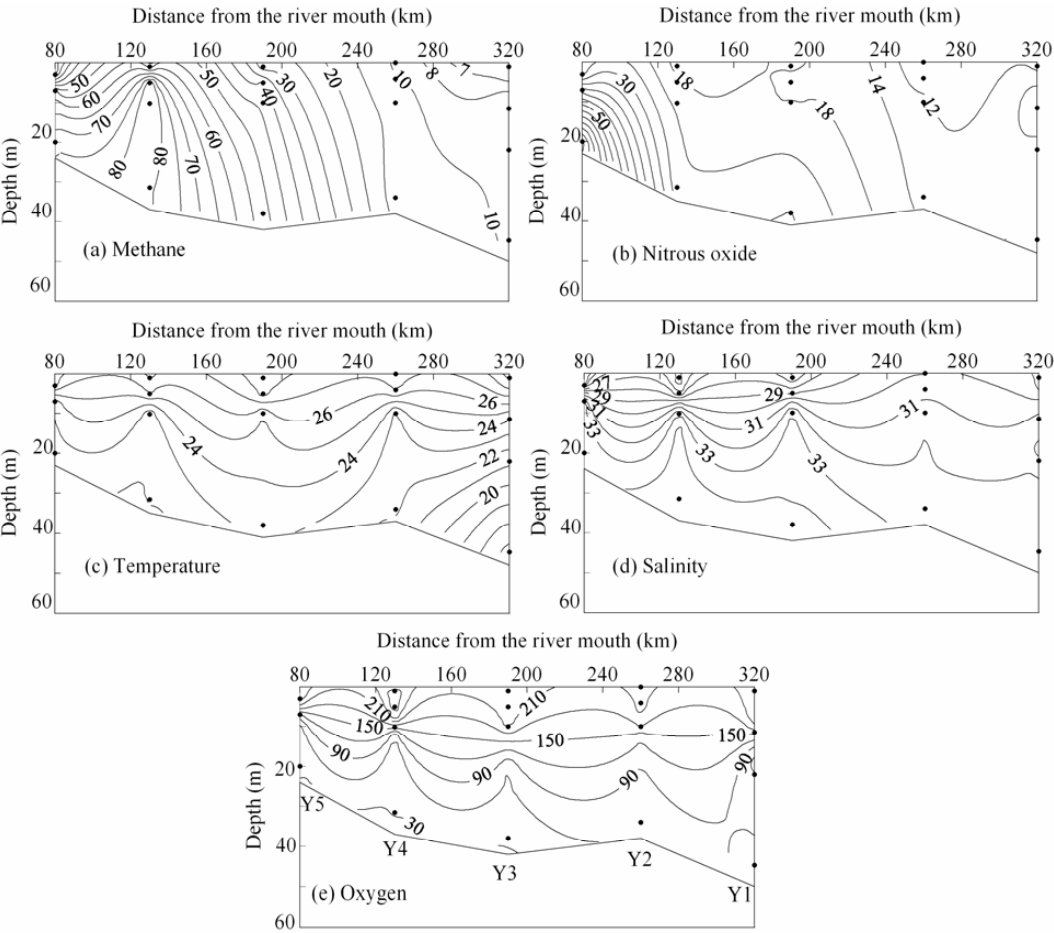
Fig. 9. Distribution of hydrographic and chemical properties in the East China Sea from a station outside Changjiang Estuary (Y5) to the Korea Strait (Y1) in September 2003: (a) CH 4 (nM), (b) N 2 O (nM), (c) temperature ( ◦ C), (d) salinity, and (e) dissolved O 2 (µM). Modified from Zhang et al.